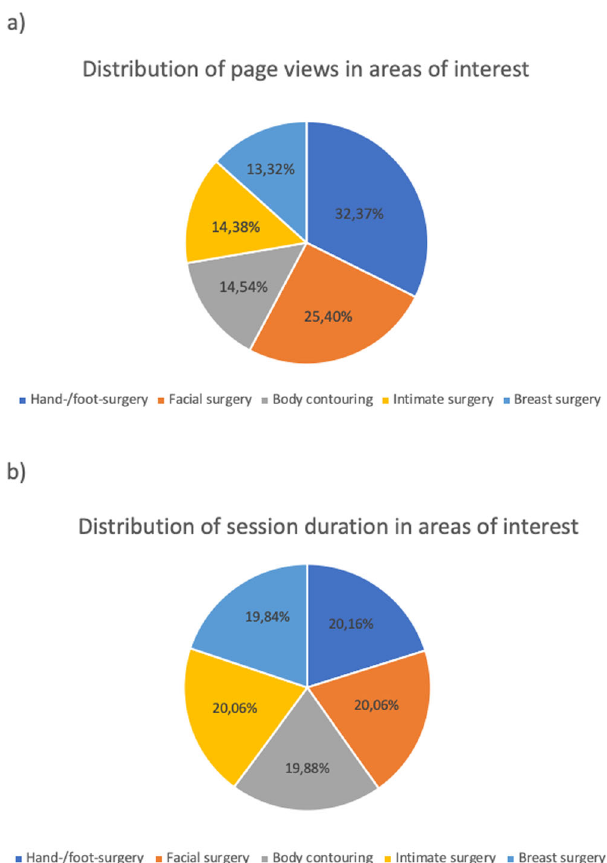
Fig. 4 Areas of interest during lockdown. Distribution of page views (above, a ) and session duration (below, b ) when looking at the different areas of interest after the beginning of the